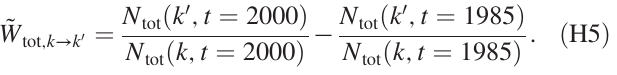
TABLE V. List of regions (which we name based on the current administrative regions) with nonzero values of in-degree in our MRSs. Clan: figure Region In-degree Percentage of total in-degree All clans: Seoul ( 서 울 ) 109 59.9% Figs. 15(a) and 15(b) Hwaseong ( 화 성 ) þ Ansan ( 안 산 ) þ Osan ( 오 산 ) þ Siheung ( 시 흥 ) þ Gwacheon ( 과 천 ) þ Gunpo ( 군 포 ) þ Euiwang ( 의 왕 ) of Gyeonggi Province ( 경 기 도 )